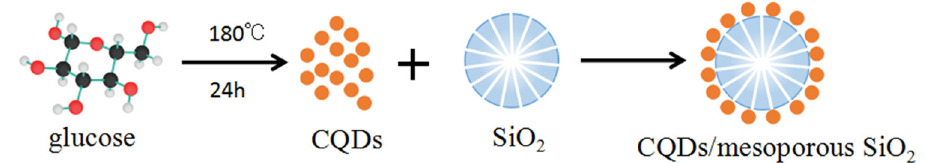
Scheme 1: Schematic diagram for the synthesis of CQDs/mesoporous SiO 2